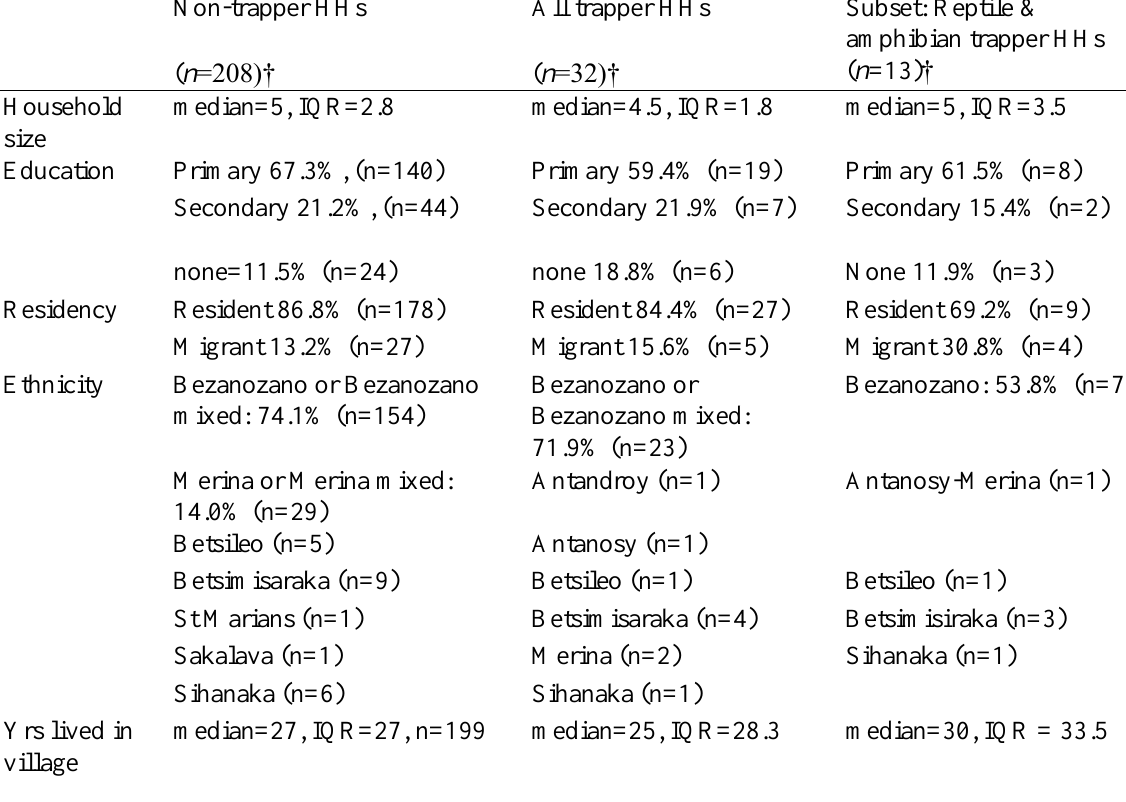
Table A3.1. Selected demographic information for systematically sampled non-trapping households (HHs), wildlife trapping households and households only involved in trapping reptiles and